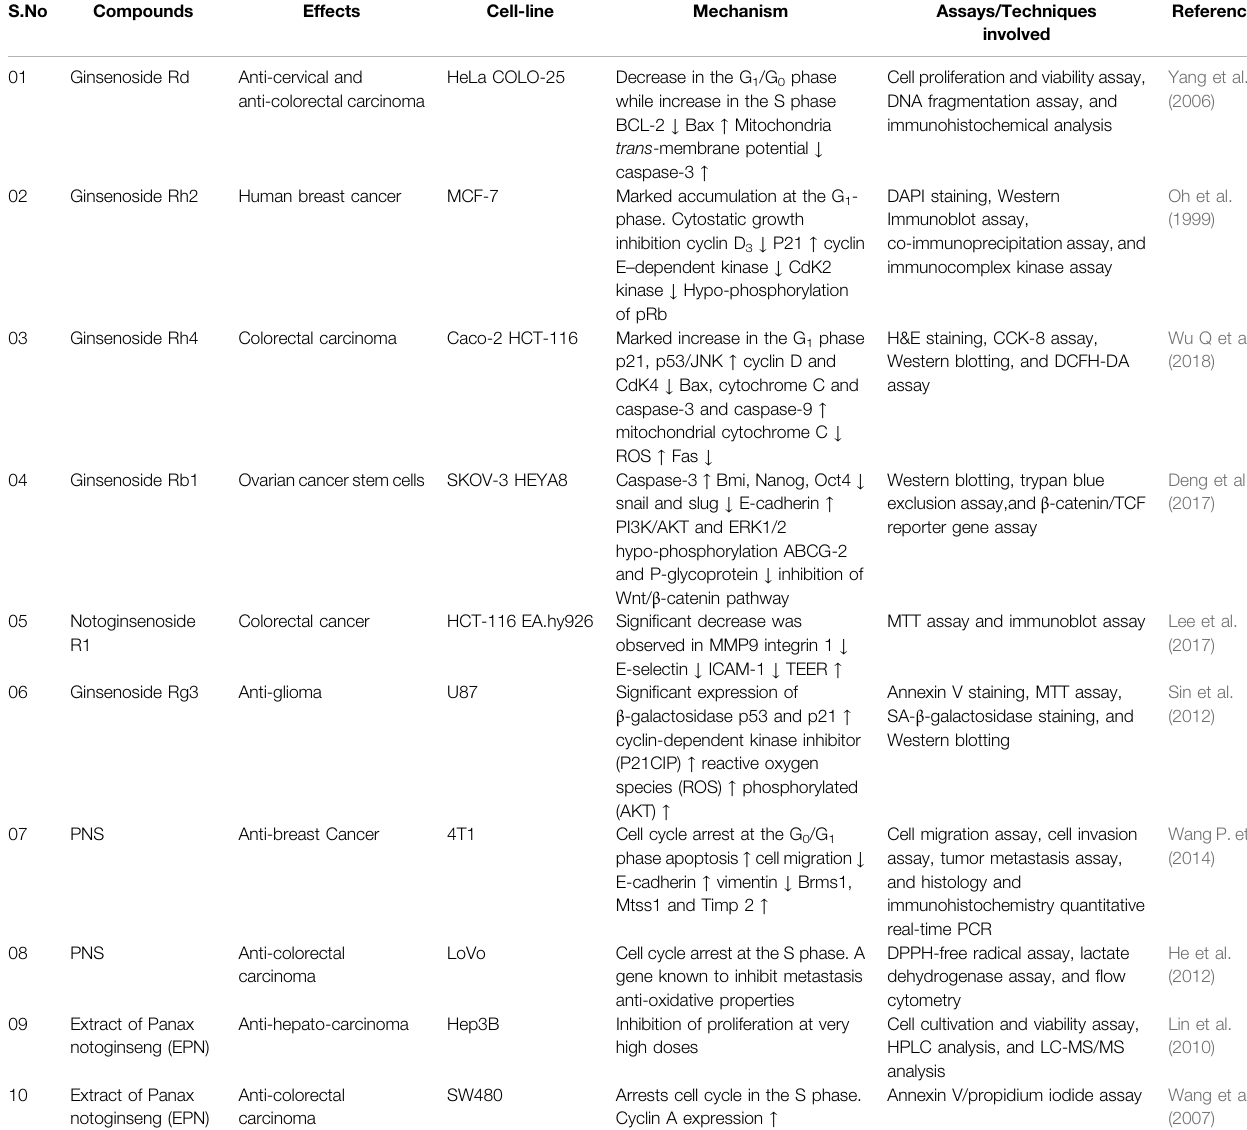
TABLE 1 | Anti-cancer activities of Panax notoginseng compounds, their effects, and mechanism of action.